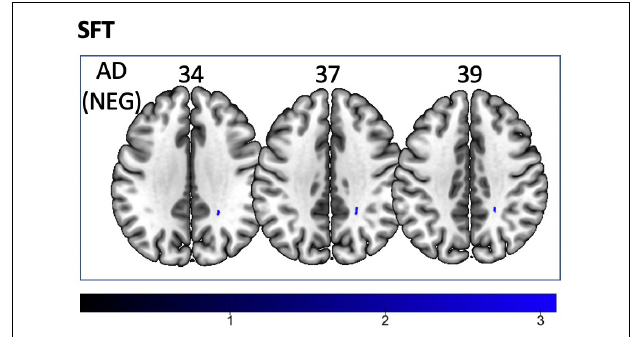
( Figure 5A ) and RD ( Figure 5B ) and BNT scores within both the left SLF, and the right inferior fronto-occipital fasciculus. Finally, there were no significant correlations between DTI metrics and CI-BDAE. The MNI values for the results of each regression analysis between each of the language tests and DTI metrics are provided in Tables 2 – 5 .